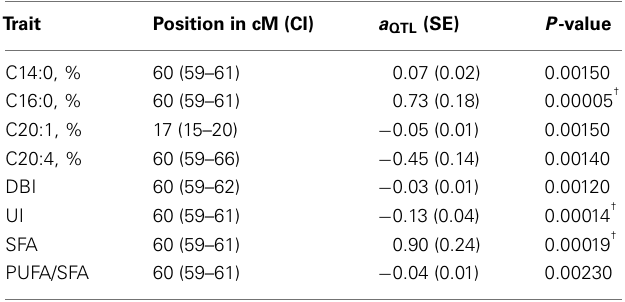
Table 2 | Most relevant results of a QTL scan for fatty acid composition of intramuscular fat.